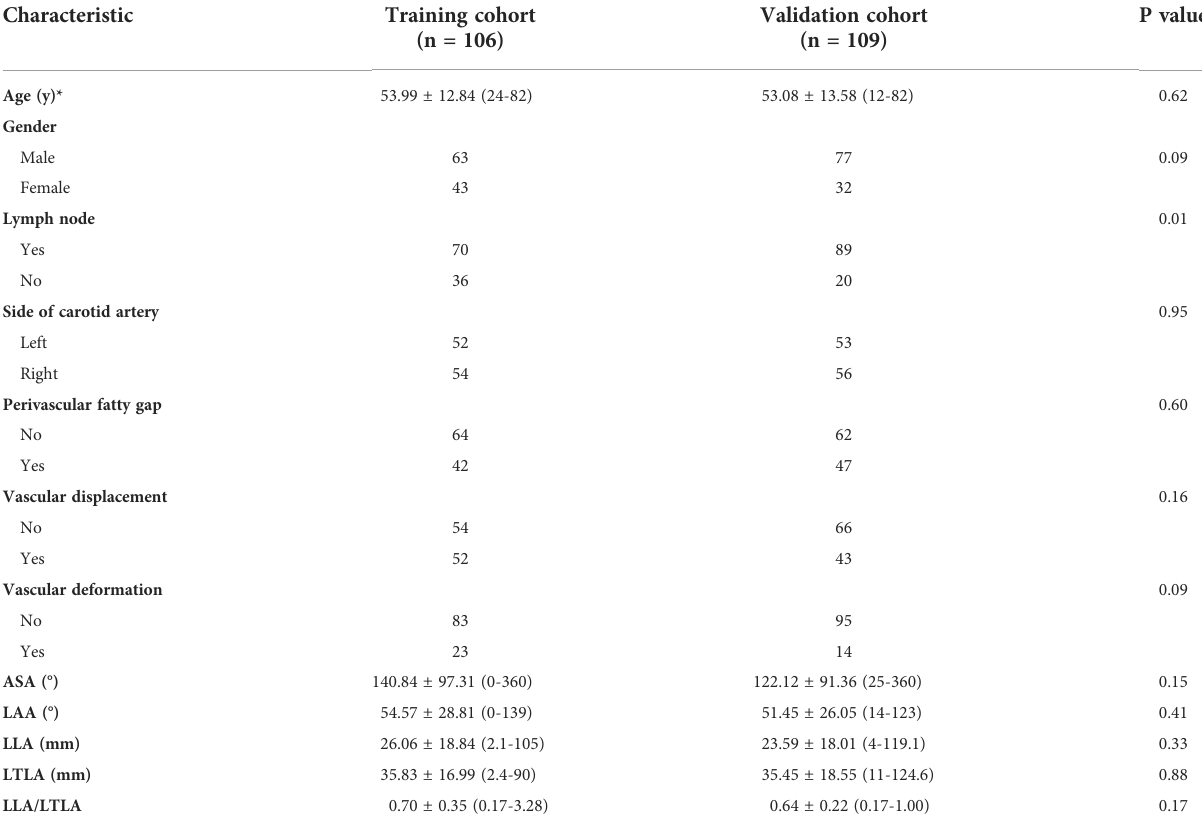
TABLE 1 Characteristics of patients in the training and validation